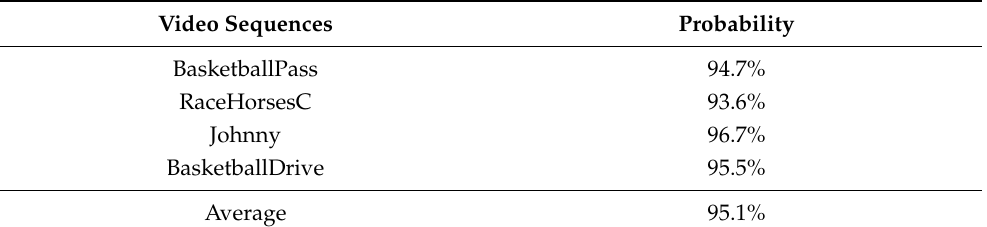
Table 2. The probability of using the same optimal transform in two adjacent sub-CUs under binary